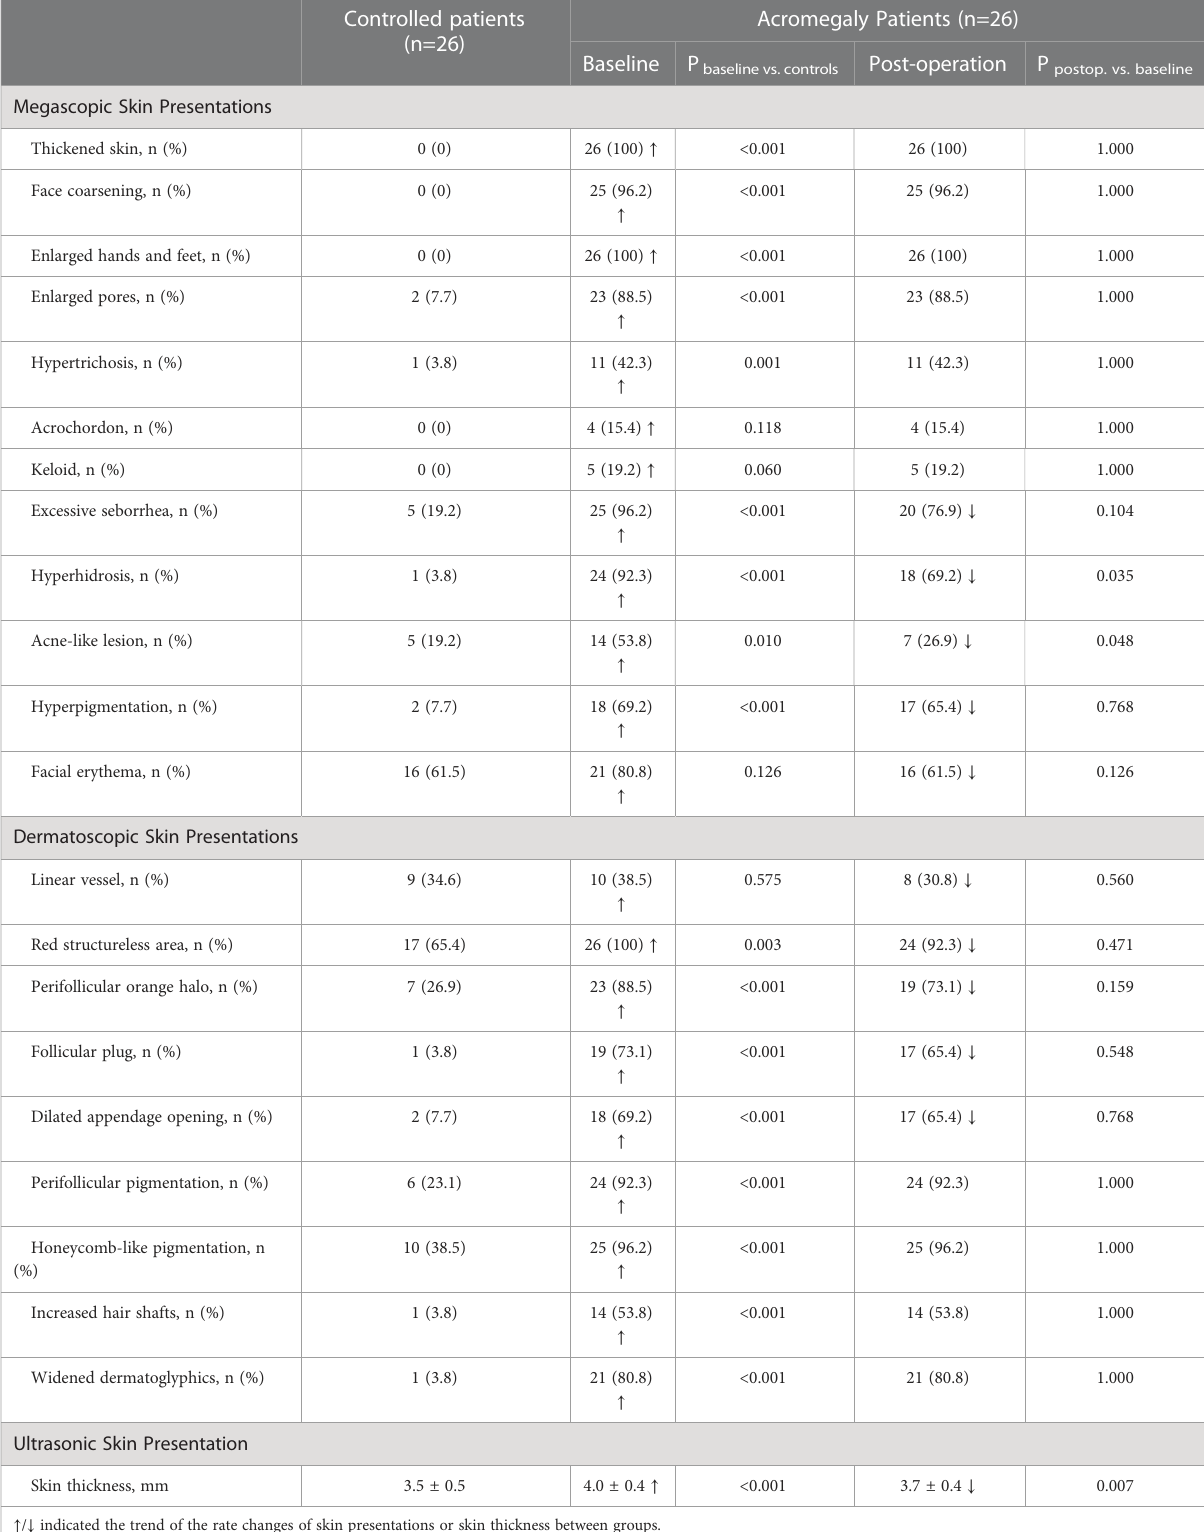
TABLE 2 Megascopic, dermatoscopic, and ultrasonic skin presentations of acromegaly patients and the effect of transsphenoidal pituitary tumor